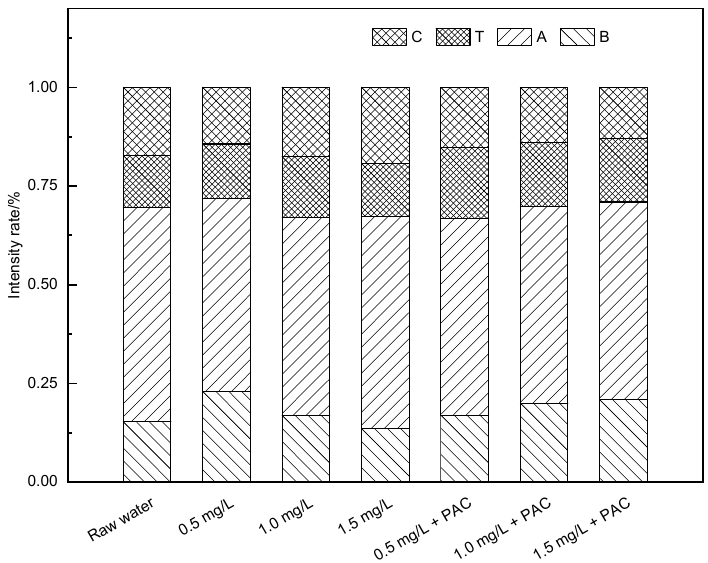
Figure 8. Proportion of the standard volume integral intensity of an O 3 pre-oxidation hydro fluorescent spectra.